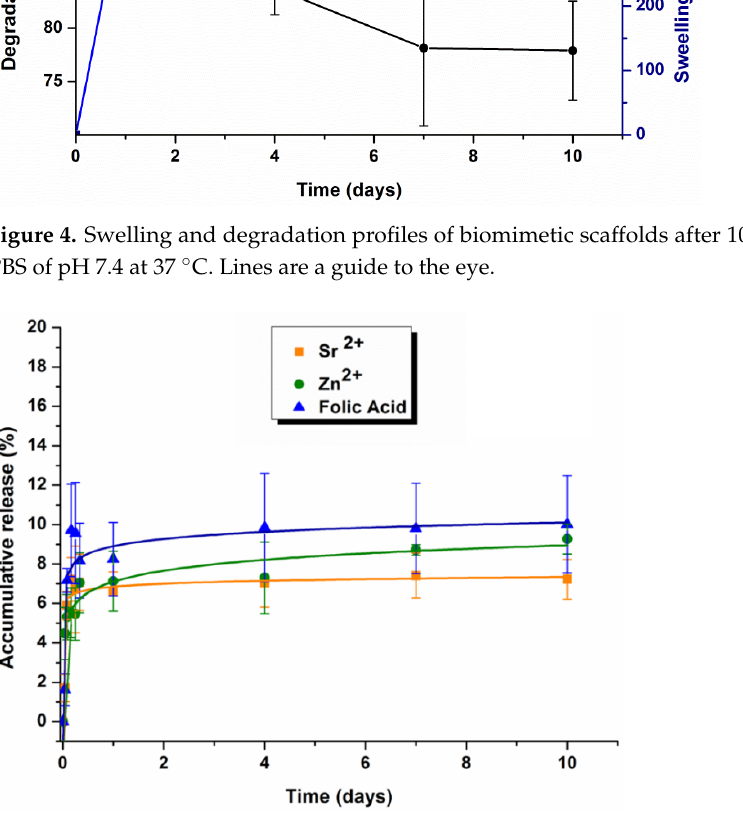
Figure 4. Swelling and degradation profiles of biomimetic scaffolds after 10 days of immersion in PBS of pH 7.4 at 37 °C. Lines are a guide to the eye.